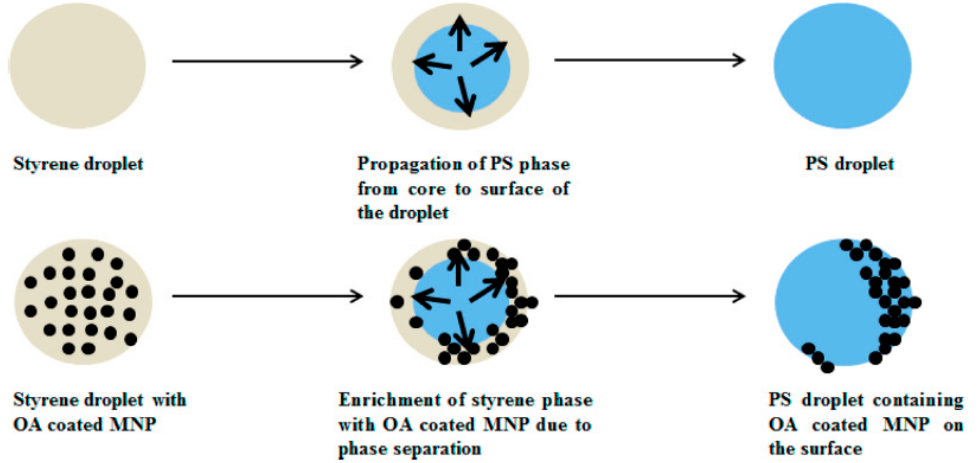
Figure 21. Schematic representation of ionic liquid-based surfactant-mediated fabrication of nanoparticles of polystyrene (PS) without and with magnetic properties (MNP) [234]. Reprinted with permission from ref. [234]. Copright 2021 ACS Publications.